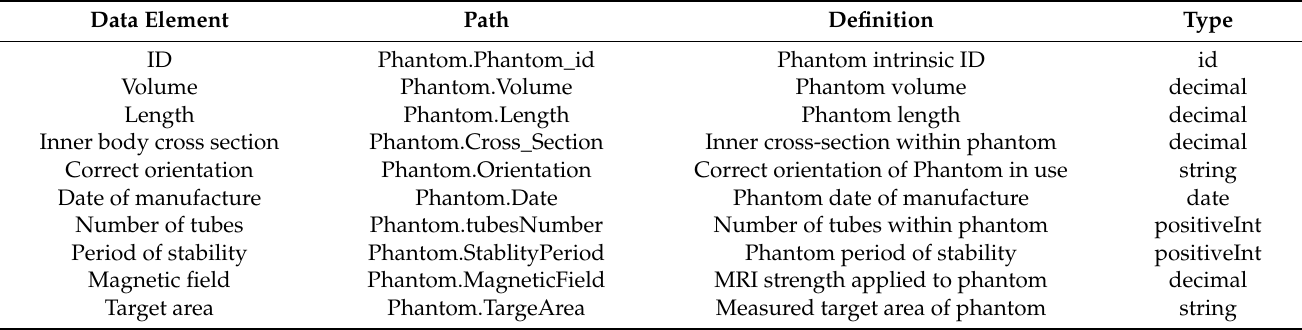
Table 6. Example of Phantom Data Element Profiling.